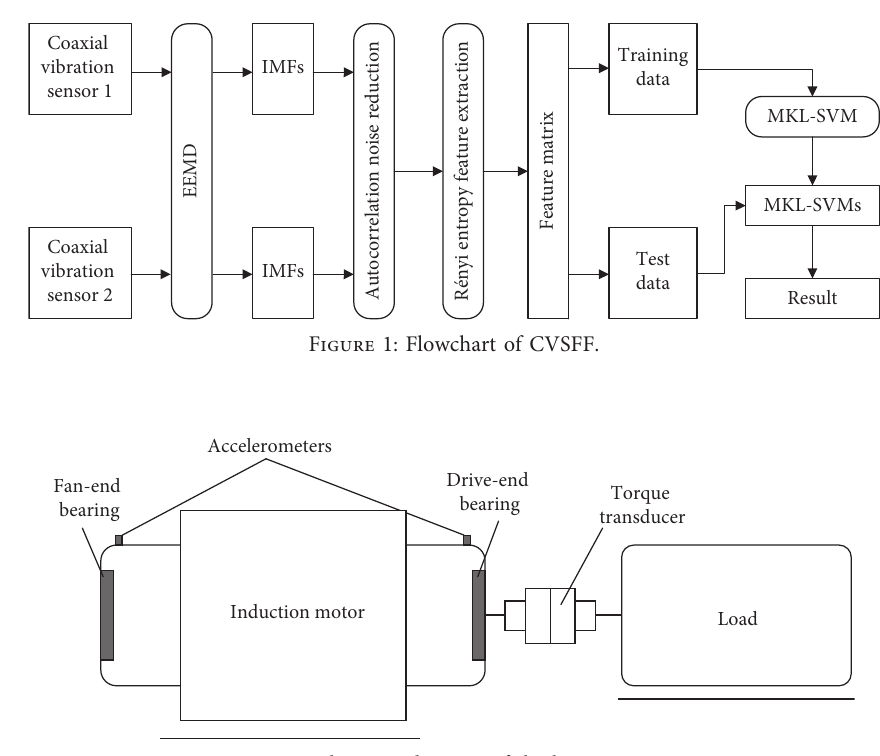
Figure 2: Schematic diagram of the bearing test rig. Table 1: Data